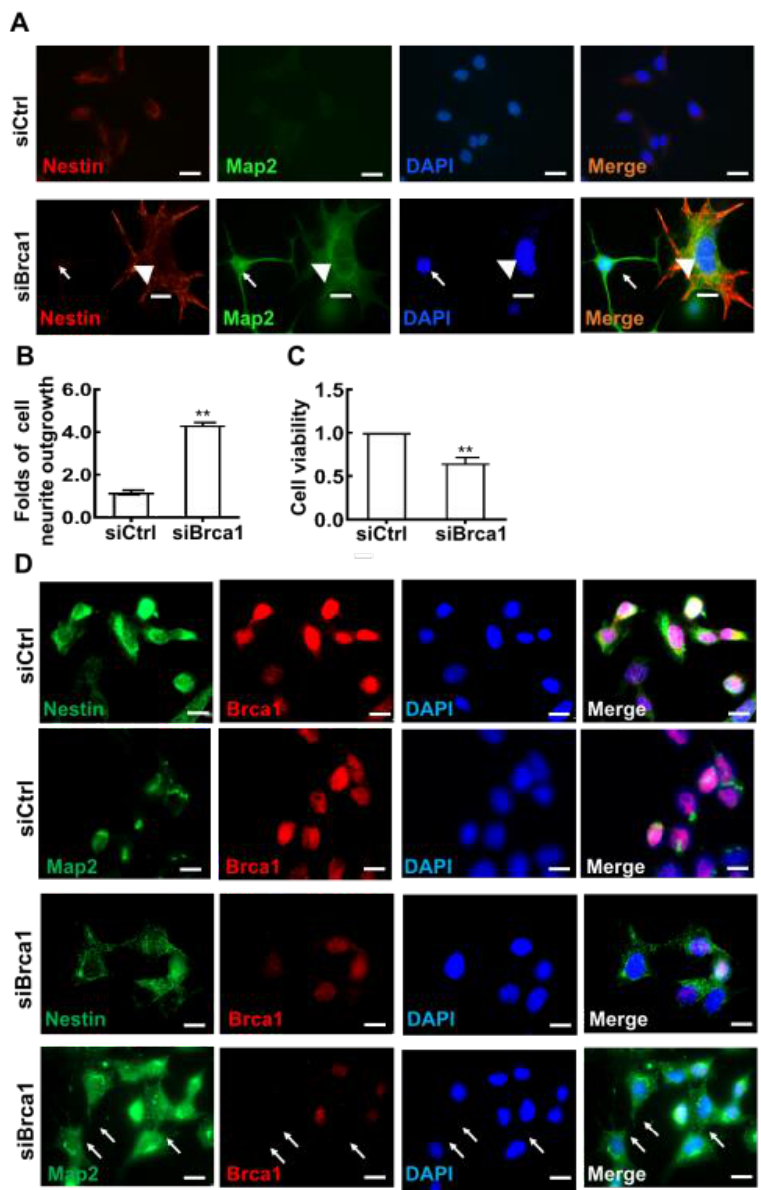
Figure 2. Brca1 is involved in the differentiation of 661W cells. ( A , D ), Brca1 interference decreased Nestin expression (red, cell cytoplasm) while increasing Map2 expression in 661W cells (green, cell cytoplasm). The cell nuclei were stained with DAPI (blue). The white arrows indicate dendrites or neurites stained by Map2 , the white arrowhead indicates neurite stained by Nestin . ( B ) Brca1 silencing promoted retinal neurite outgrowth. Scale bars represent 20 µ m. ( C ) Brca1 interference by siRNA inhibited the viability of 661W cells. The asterisks indicate statistically significant differences (** p < 0.01).